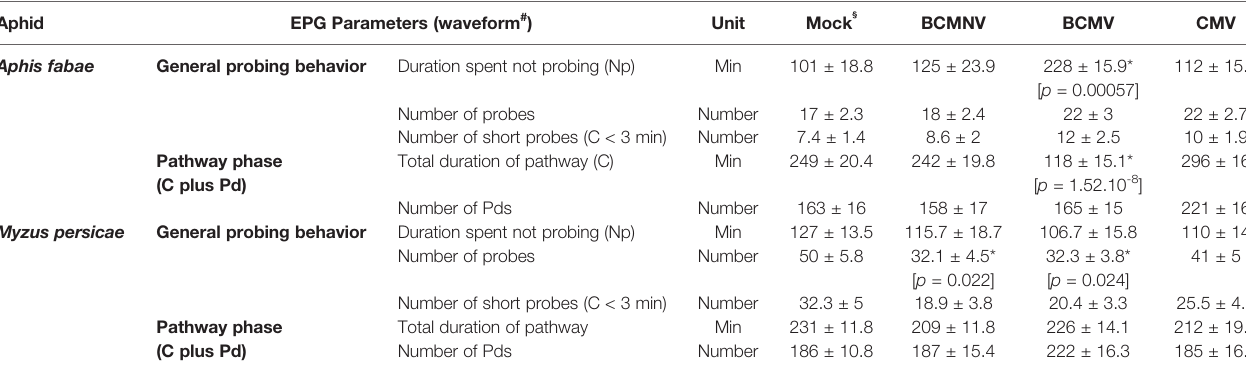
Asterisk (*) indicates that the Bonferroni corrected p value, associated with behavioral comparisons on virus-treated vs mock inoculated plants, was signi fi cant to the 0.05 level (p-values were obtained using Dunnett post hoc tests from GLM models, see statistical analyses, main